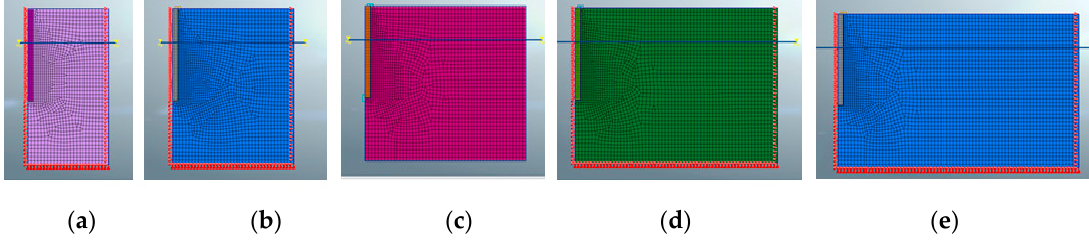
Figure 6. Five finite element models with different widths. ( a ) 10 m × 16 m, ( b ) 15 m × 16 m, ( c ) 20 m × 16 m, ( d ) 25 m × 16 m, ( e ) 30 m × 16 m.